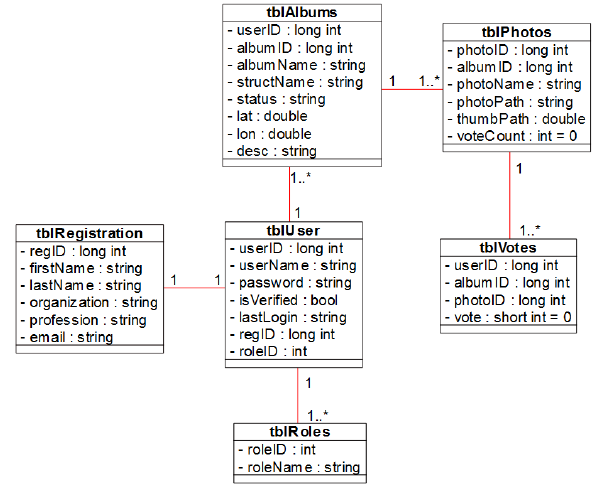
Figure 3. Use case diagram (UCD)